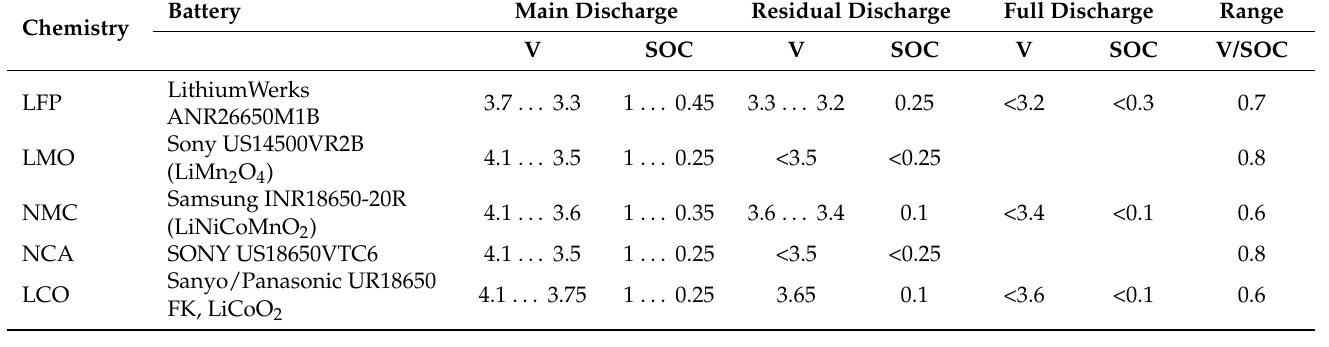
Table 4. Voltage range (in V) as a function of state-of-charge of lithium-ion batteries during discharge.